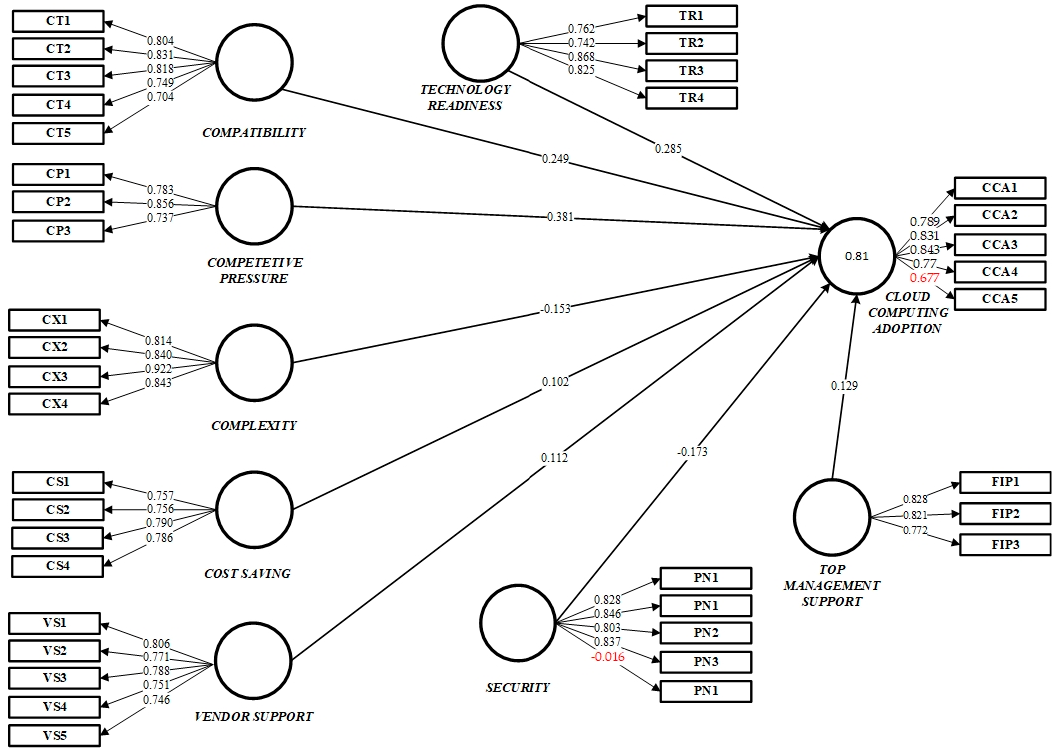
Figure 1. Proposed Figure 1. Proposed model